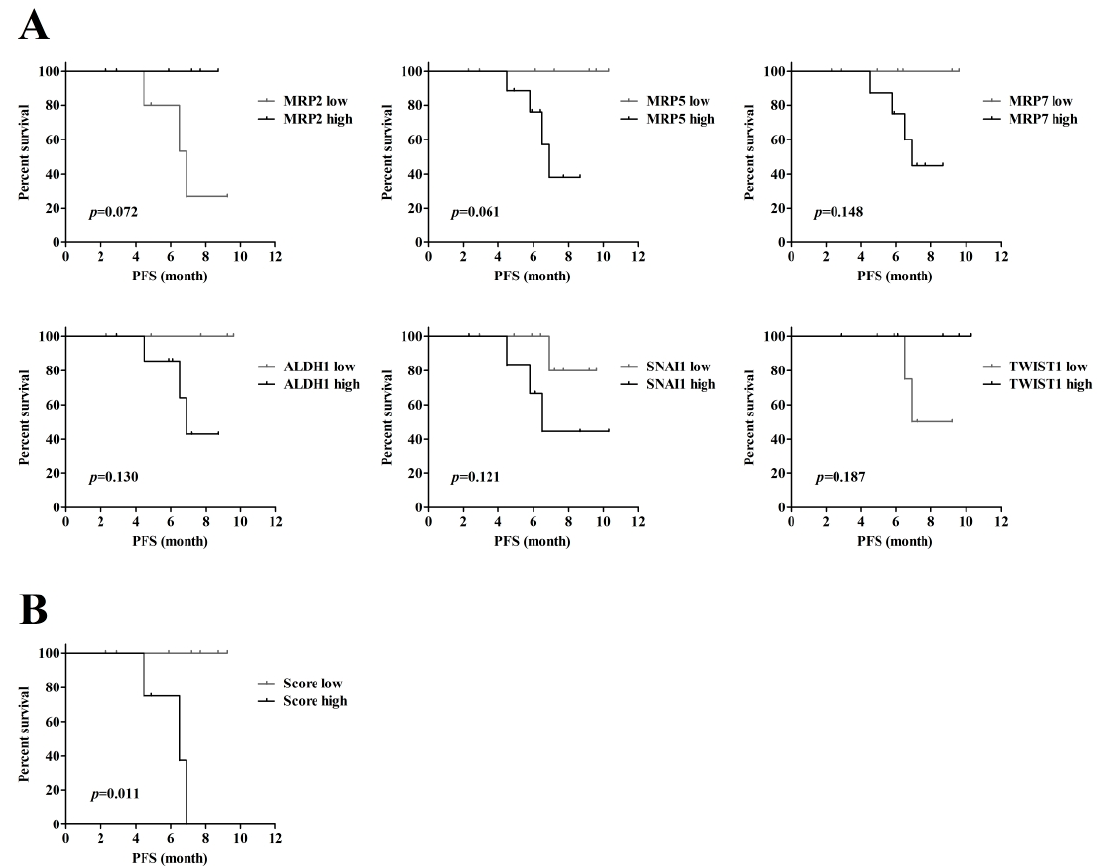
Figure 3. The survival curves of patients who were dichotomized according with the expression of individual cancer-related genes ( A ) or with the risk-score ( B ).